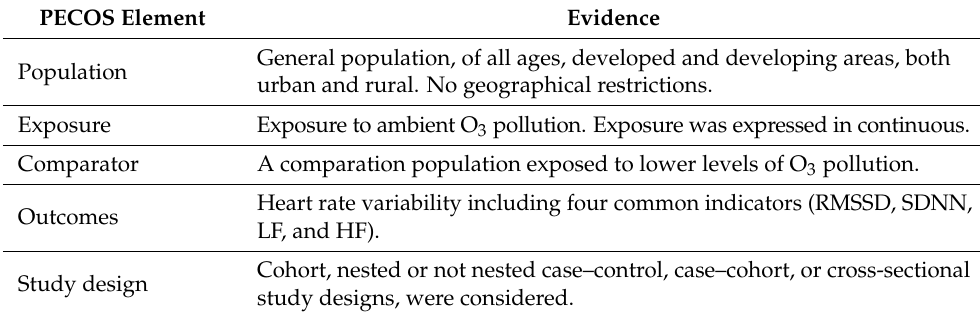
Table 1. PECOS for epidemiology study